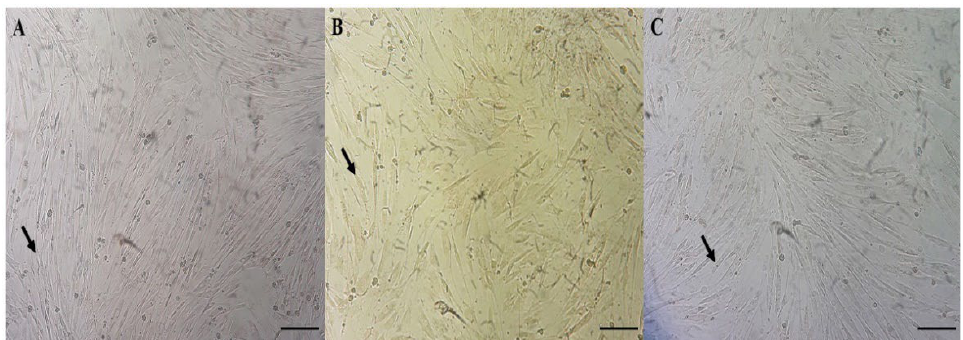
Figure 2. Morphological analysis of cells obtained from the abdominal region of domestic cat exposed to 20% Jurema preta extract and 2% iodine solution. ( A ) 0% Jurema preta (M. tenuiflora) extract (negative control), ( B ) 20% Jurema preta ( M. tenuiflora ) extract, and ( C ) 2% iodine solution at (positive control), 40×. Arrow indicates cells with fibroblast-like morphology.